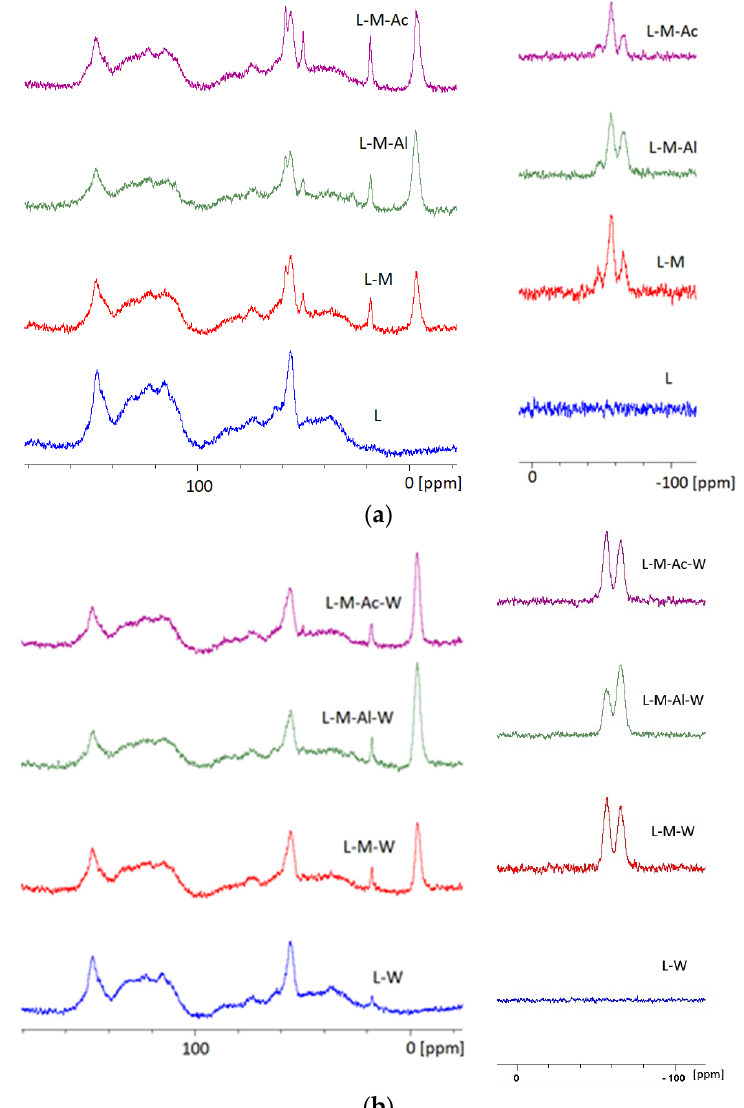
Figure 6. Spectra: ( a ) 13 C and 29 Si NMR of lignin; ( b ) 13 C and 29 Si NMR of lignin after leaching.